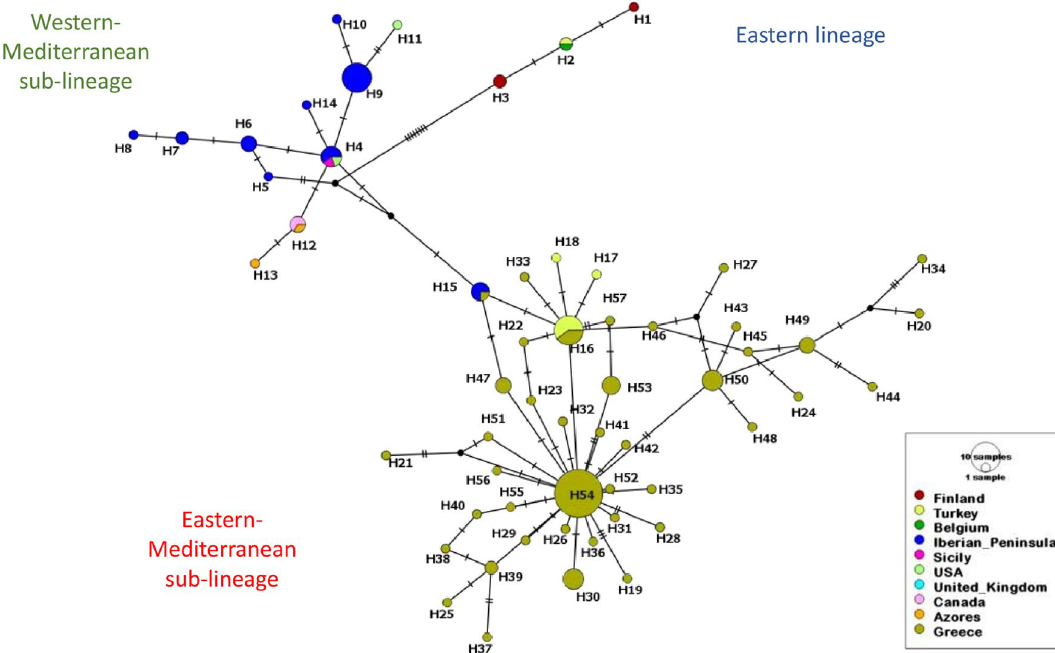
Figure 3. Haplotype cytb network of Philaenus spumarius from Greece and selected haplotypes found in rest of the species range. Each colour indicates a different geographic area. Size of the circles represent the frequency of each haplotype among individuals. Hatch marks along the branches indicate the numbers of mutations and black dots represent unsampled and hypothetical haplotypes. Size of the lines are in proportion with the number of base